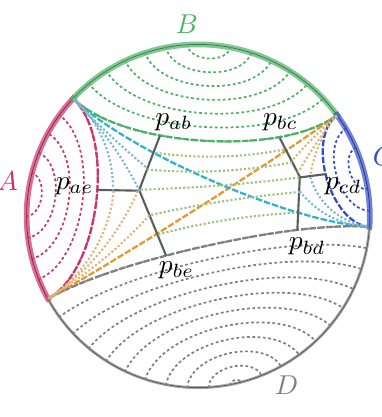
Figure 6 . A local foliation designed to obtain the thread bundles indicated in (cid:12)gure 4b. The 6 black line segments along with the 4 minimal surfaces break up the bulk into 9 di(cid:11)erent regions, each foliated by its own family of